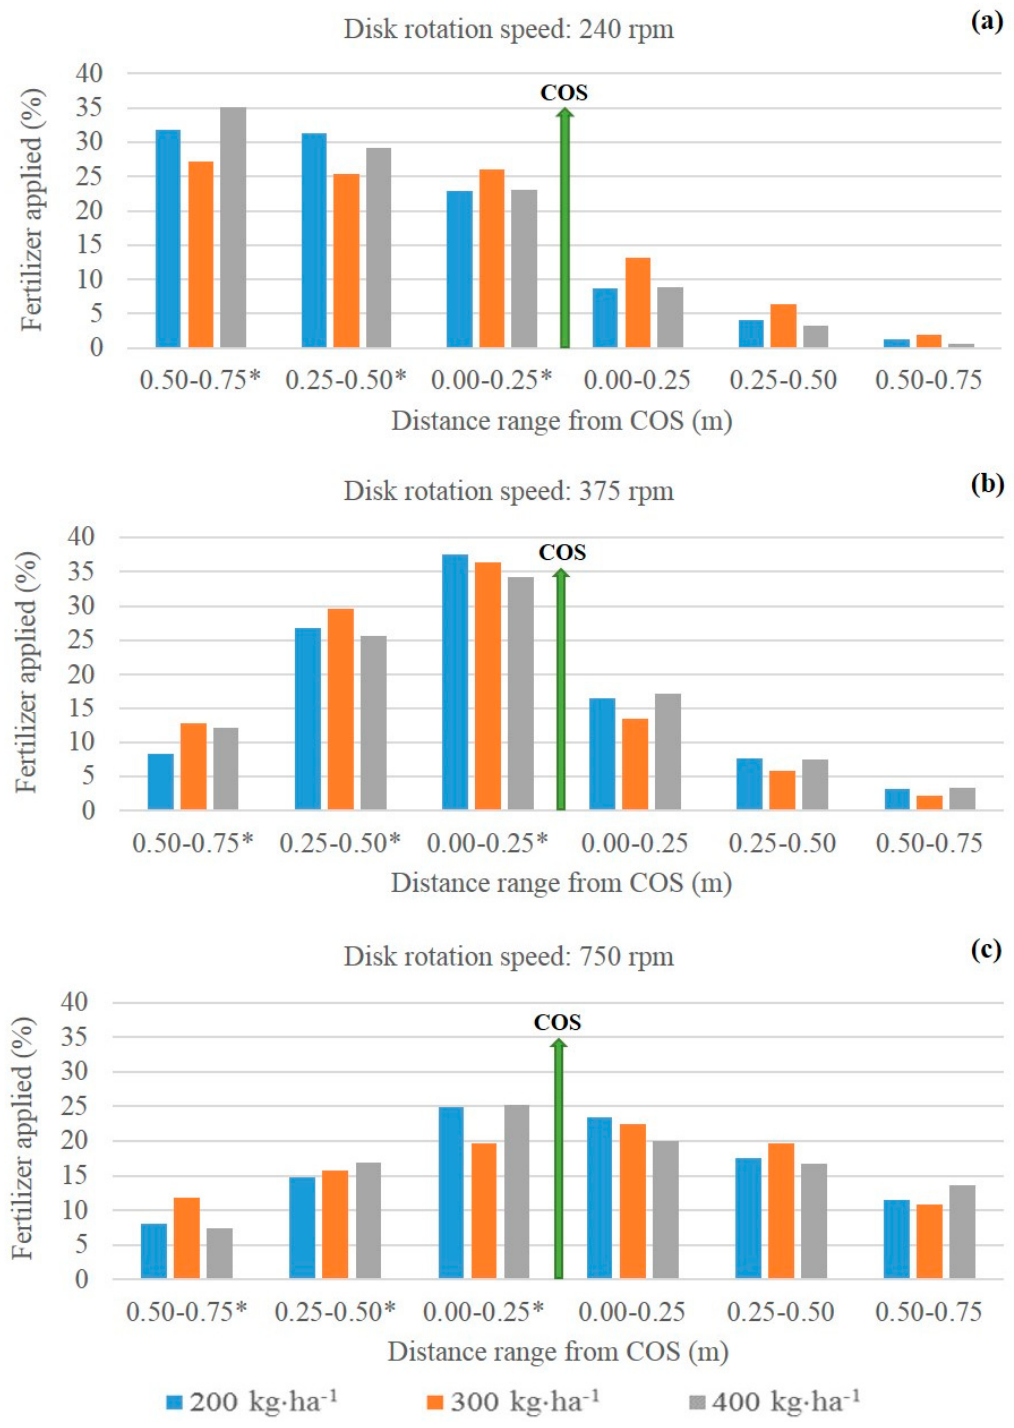
Figure 4. Transverse distribution profile histograms showing the percentage of fertilizer applied to different distance ranges from the coffee plant’s orthotropic stem (COS) for application on one side of the coffee plants (FA1) at three fertilizer doses and three spreading disk rotation speeds: ( a ) 240 rpm; ( b ) 375 rpm; ( c ) 750 rpm. * Positions located on the side of the coffee plants where the spreader travels when applying fertilizer.